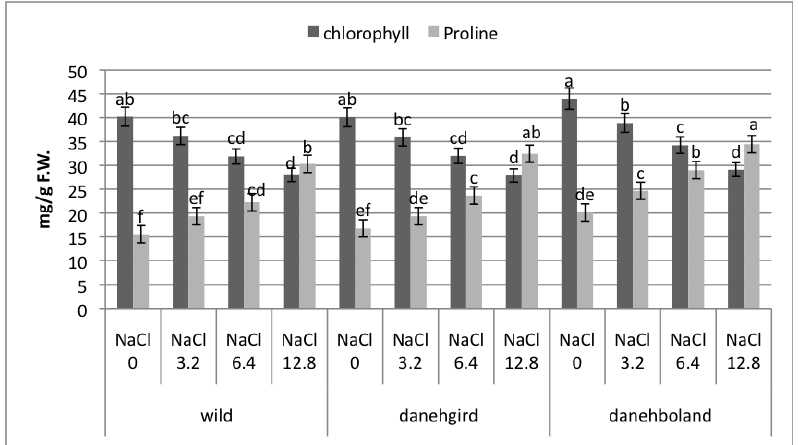
Fig. 2: Sodium chloride effect on leaf total chlorophyll (mg g -1 F.W.) and leaf proline content (µmole g -1 F.W.) of non-grafted wild, grafted ‘Danehgird’ and ‘Danehboland’ cultivars of Z. spina-christi . In each measured factor (chlorophyll, proline), means followed by the same letter are not significantly different at p≤0.05, using Tukey’s test. The data are the means±SE (n=8).